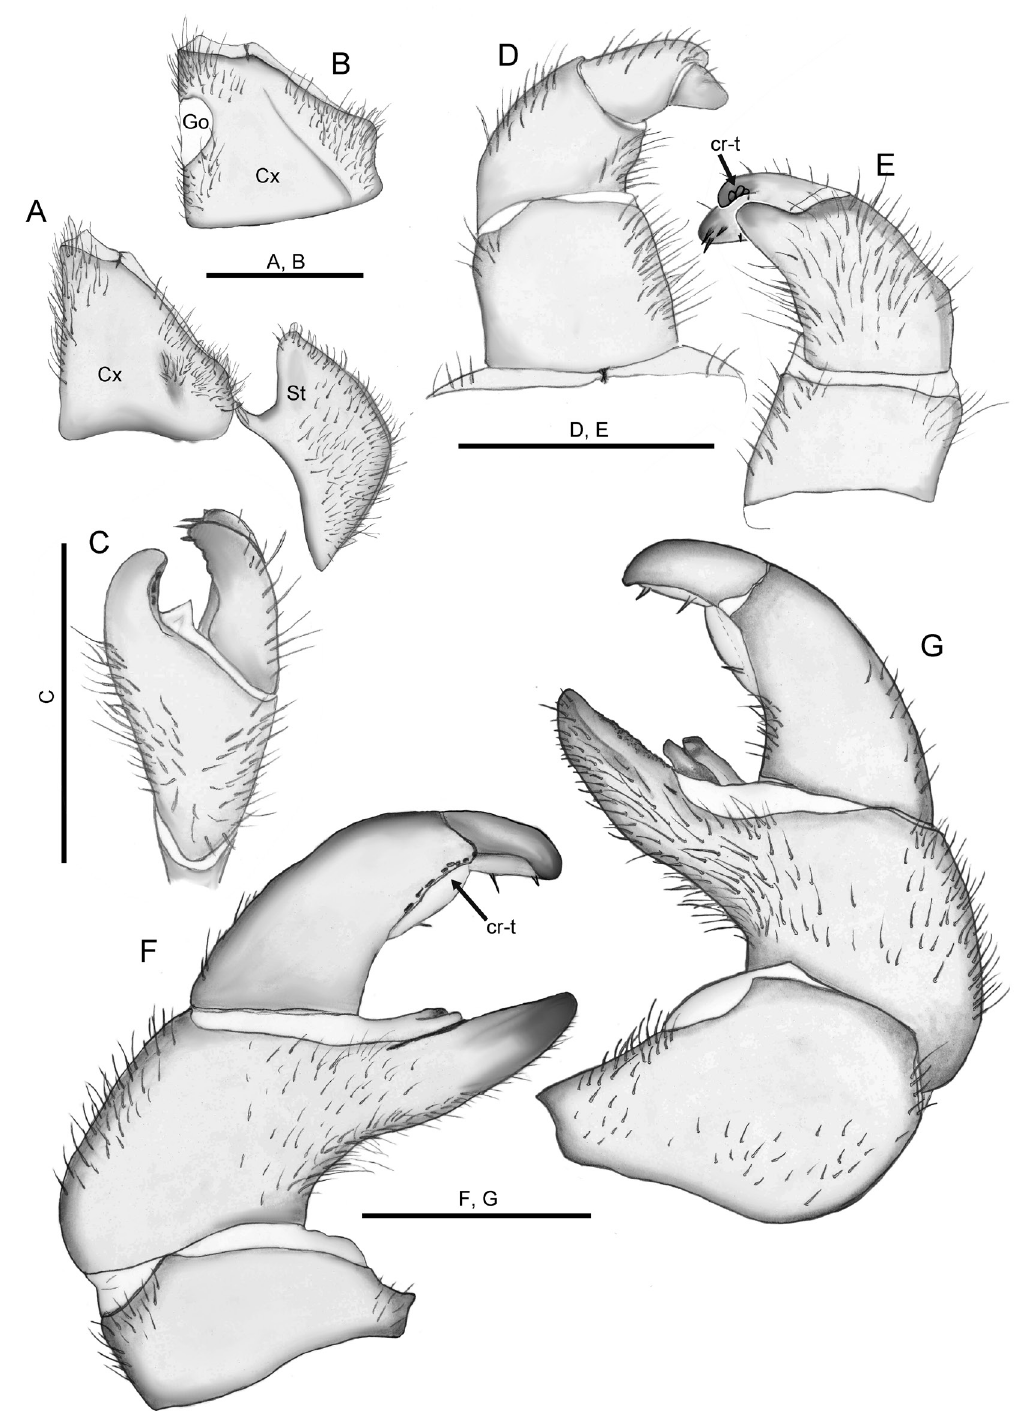
Fig. 10. Zephronia viridisoma Rosenmejer & Wesener sp. nov., holotype, ♂ (NHMD 621695), drawings. A . Coxa of first left leg with stigmatic plate, posterior view. B . Coxa of second left leg with gonopore, posterior view. C . Left anterior telopod, lateral view on podomeres 2–4. D . Left anterior telopod, anterior view. E . Left anterior telopod, posterior view. F . Right posterior telopod, posterior view. G . Right posteiror telopod, anterior view. Abbreviations: cr-t = crenulated teeth; Cx = coxa; Go = gonopore; St = stigmatic plate. Scale bars = 1